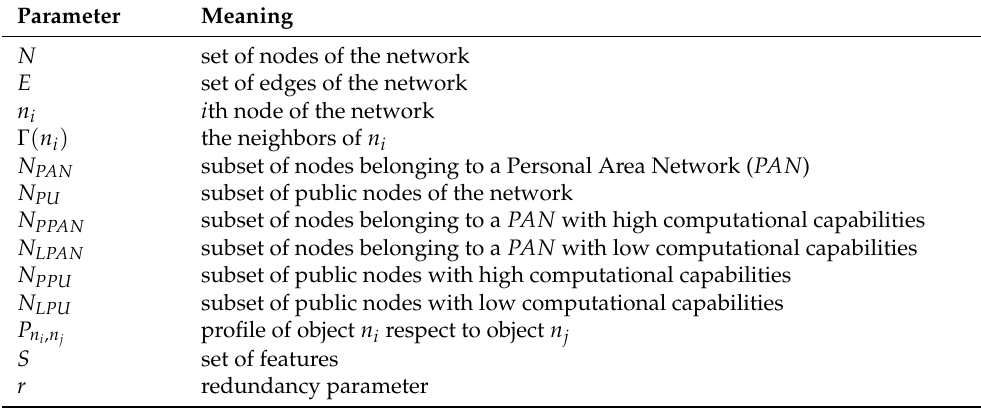
Table 2. Notation used throughout this